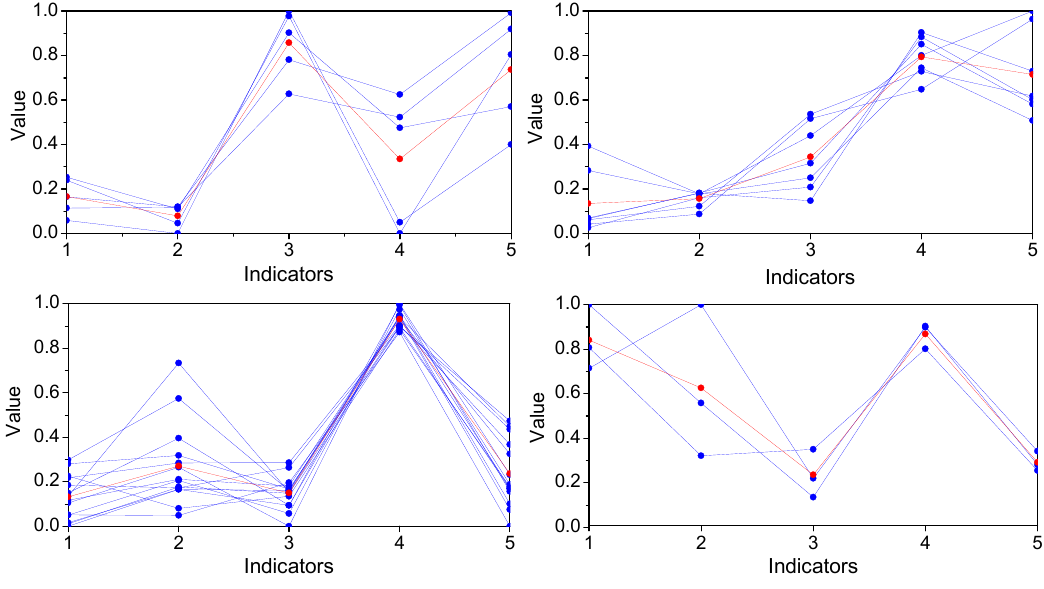
Figure 4. The carbon emission characteristics of four classes.